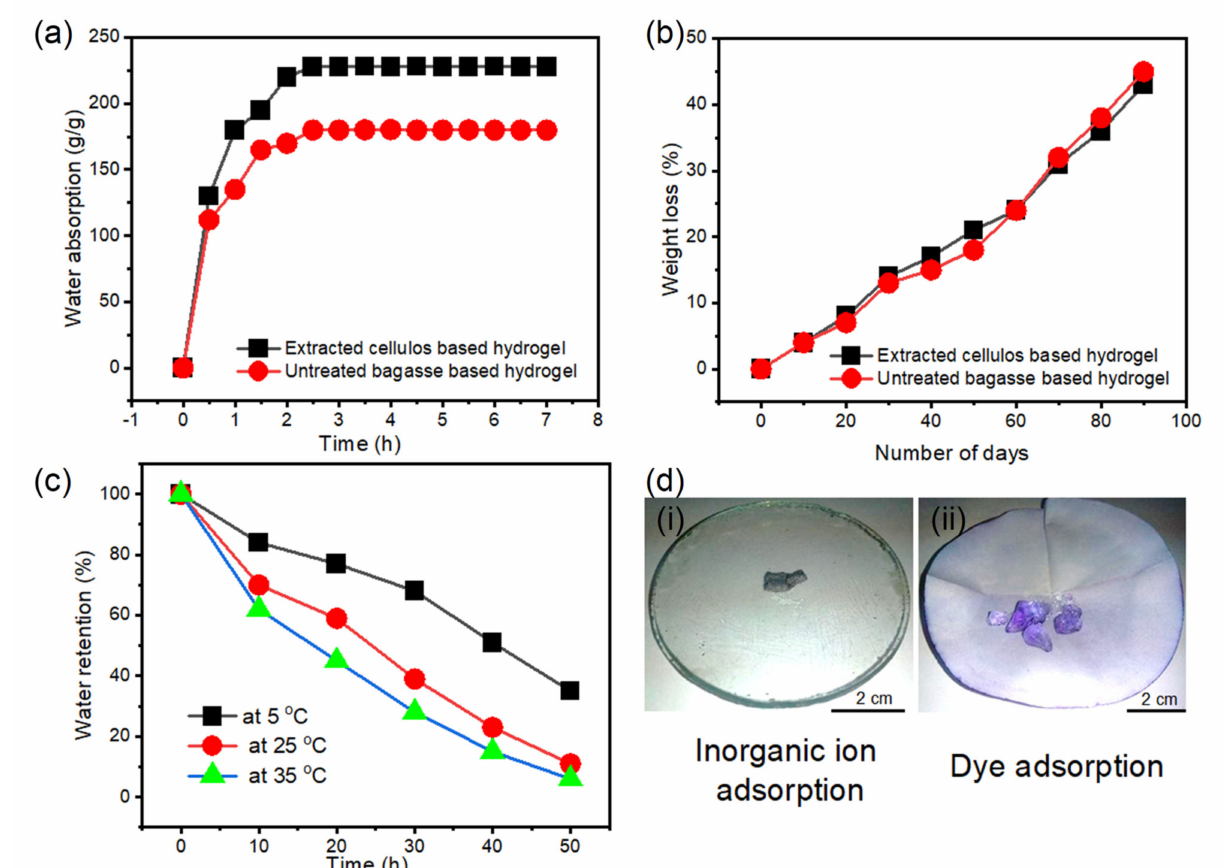
Figure 5. Time required for equilibrium water absorption ( a ); biodegradation scenario of hydrogel ( b ); water retention capacity of hydrogels at different temperatures, such as 5.0 ◦ C, 25.0 ◦ C, and 35.0 ◦ C ( c );